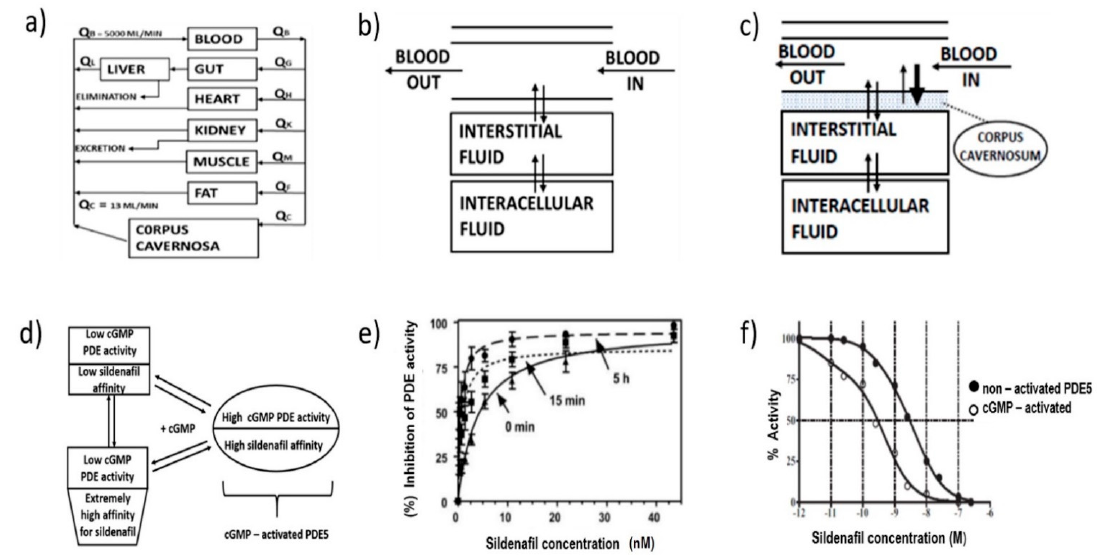
Figure 3. Pharmacodynamic profile of sildenafil: ( a ) distribution flows in a physiological map of human tissues; ( b ) schematic of artery and interstitial/intracellular medium, intracellular tissue; ( c ) schematic of artery and interstitial/intracellular medium, intracellular tissue pinpointing the corpus cavernosum compartment; ( d ) conversion of the catalytic center of the PDE5 enzyme into a higher affinity structure; ( e ) enhancement of inhibition of PDE activity by increase of sildenafil concentration (adopted from [40] with permissions) ( f ) differential affinities of sildenafil inhibition activated by cGMP (adopted from [42] with permissions).